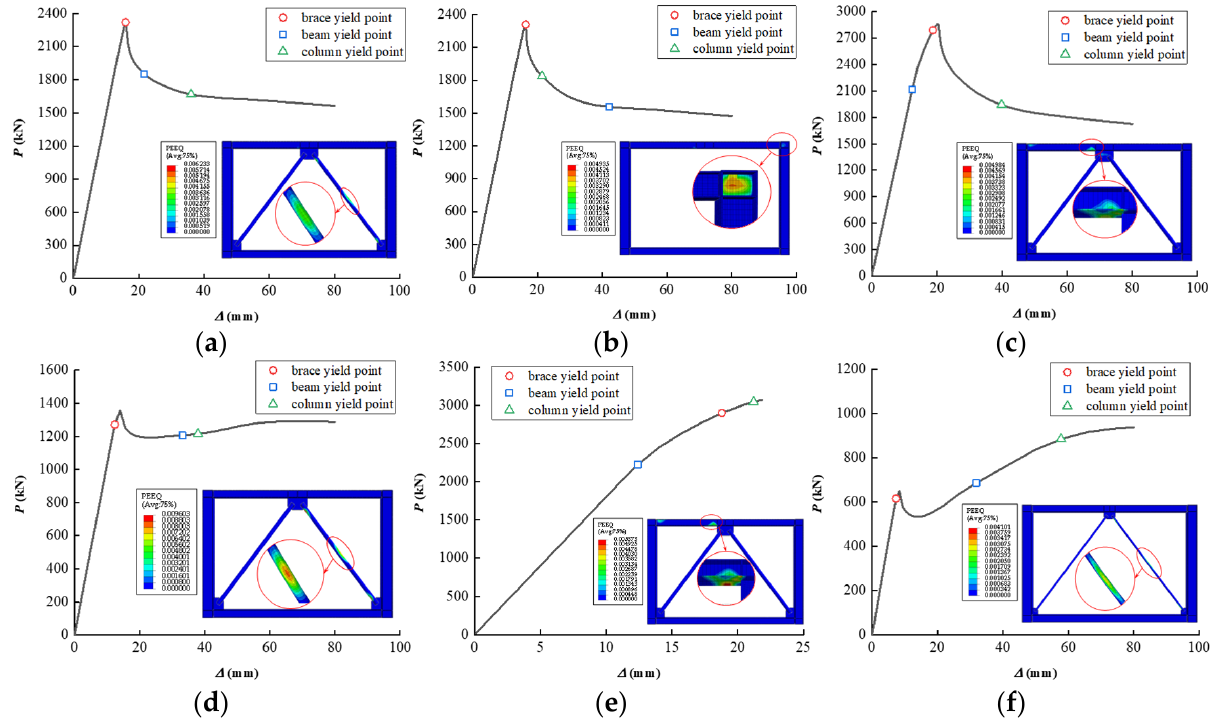
Figure 8. The predicted PEEQ (equivalent plastic strain) distributions of top floor concentrically- braced steel frames with different parameters ( η = 0). ( a ) case 1, the basic model obtained by the proposed method; ( b ) case 2, with decreased section area of the column web; ( c ) case 3, with thicker braces; ( d ) case 4, with the thinner braces; ( e ) case 5, increasing external diameter of the braces; ( f ) case 6, decreasing the external diameter of the braces.